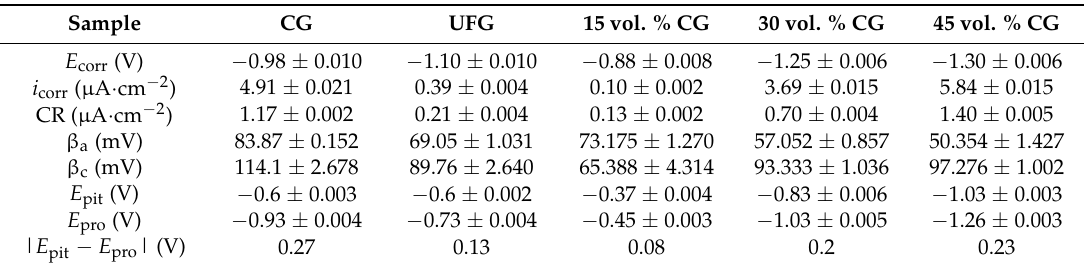
Figure 4. ( a ) Open circuit potentials and ( b ) polarization curves of CG, UFG and bimodal samples. Table 1. Corrosion parameters obtained from Tafel and cyclic polarization curves for CG, UFG and bimodal samples in 3.5% NaCl solution.